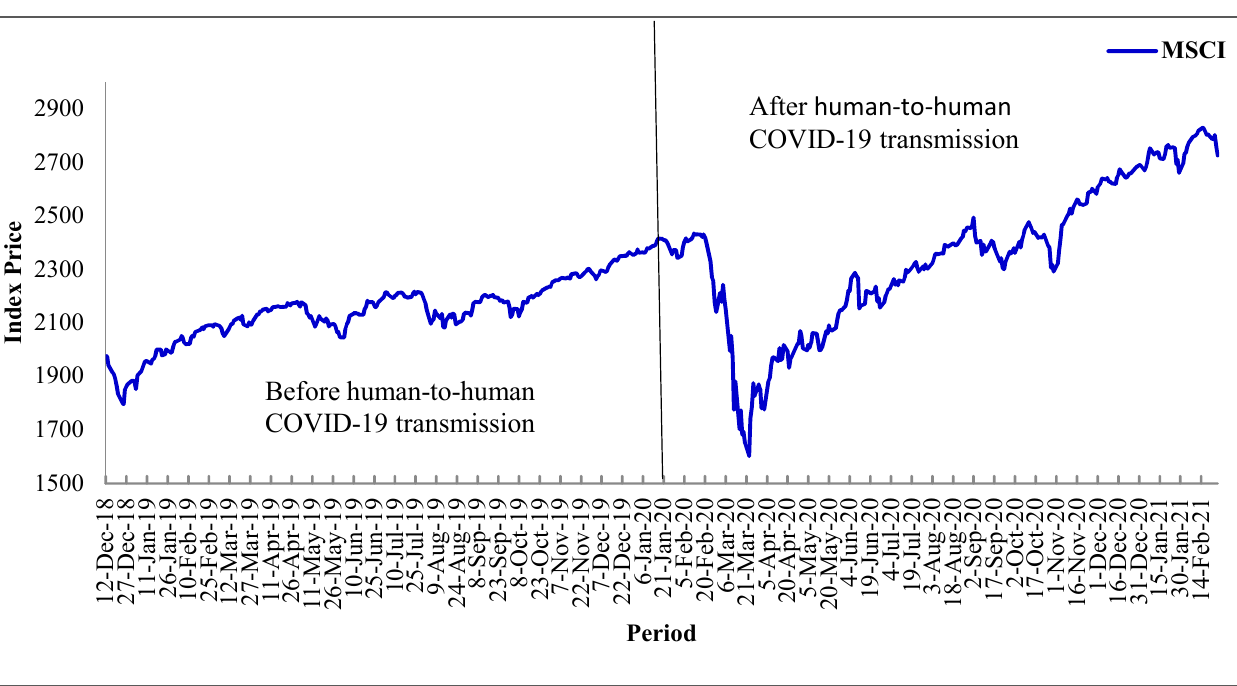
Figure 3. Daily movements of the MSCI world index (MSCI).